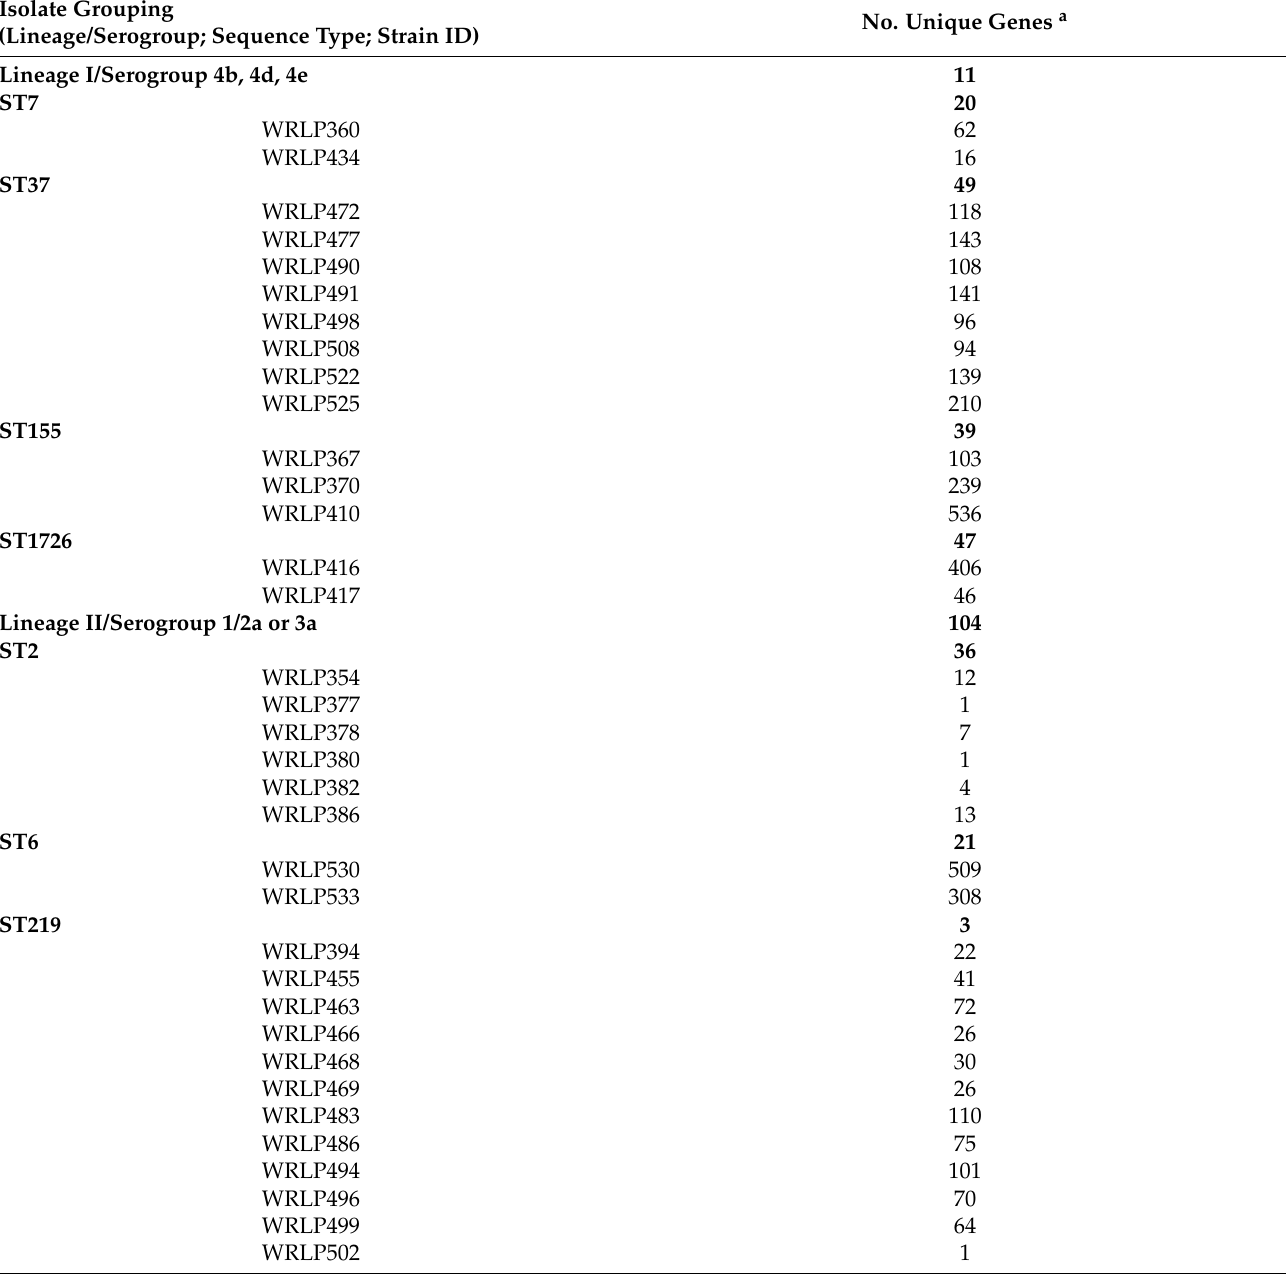
Table 2. Evaluation of accessory genomes between L. monocytogenes isolates (n = 48). The number of unique genes indicates the number of genes that were present in all genomes within the grouping (strain, ST, or lineage), but absent outside the respective